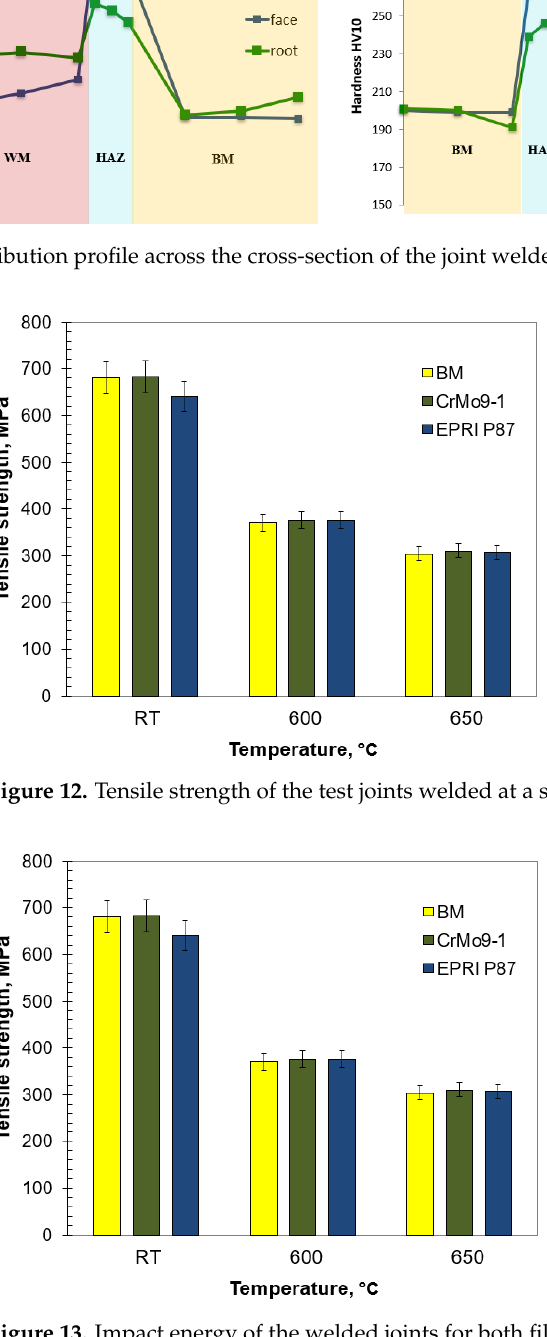
Figure 12. Tensile strength of the test joints welded at a specific temperature. Figure 13. Impact energy of the welded joints for both filler